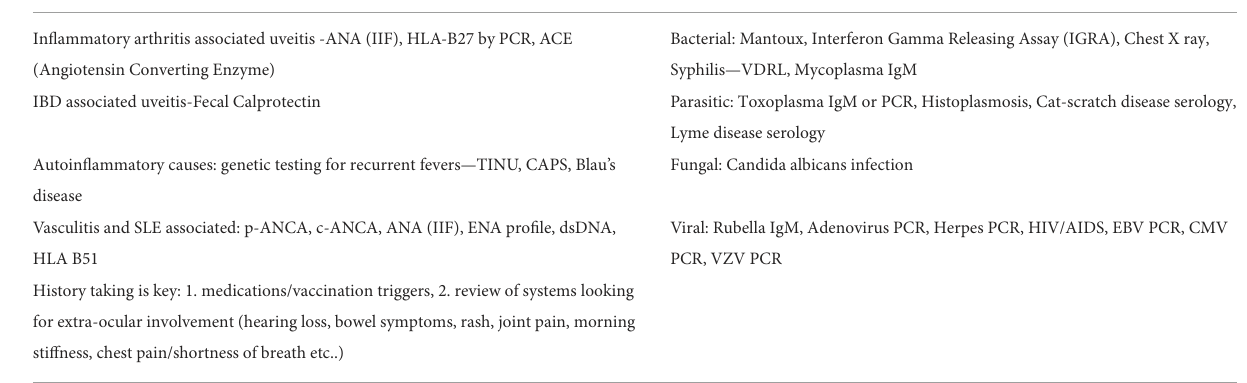
TABLE 3 Recommended baseline evaluation of uveitis by the pediatrician. Non-infectious